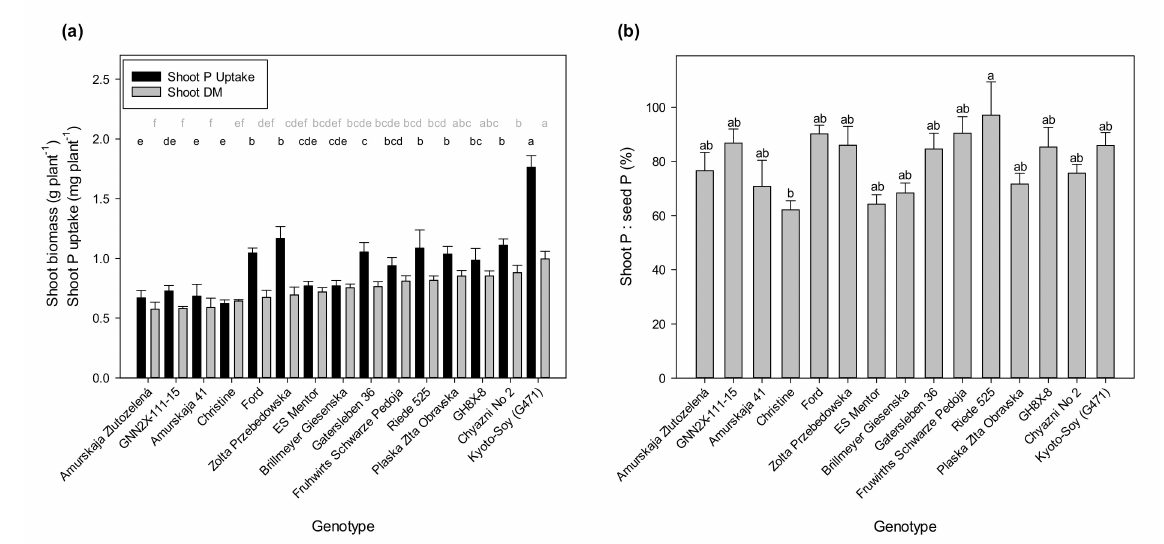
Figure 2. Experiment 1. Shoot P uptake, shoot biomass ( a ), and ratio of shoot P:seed P in percentage among the soybean genotypes, representing the relative contribution of seed P to shoot P uptake ( b ) among the soybean genotypes, sorted for shoot DM. The letters on top of each column represent Tukey’s HSD grouping. Error bars represent standard errors ( n =